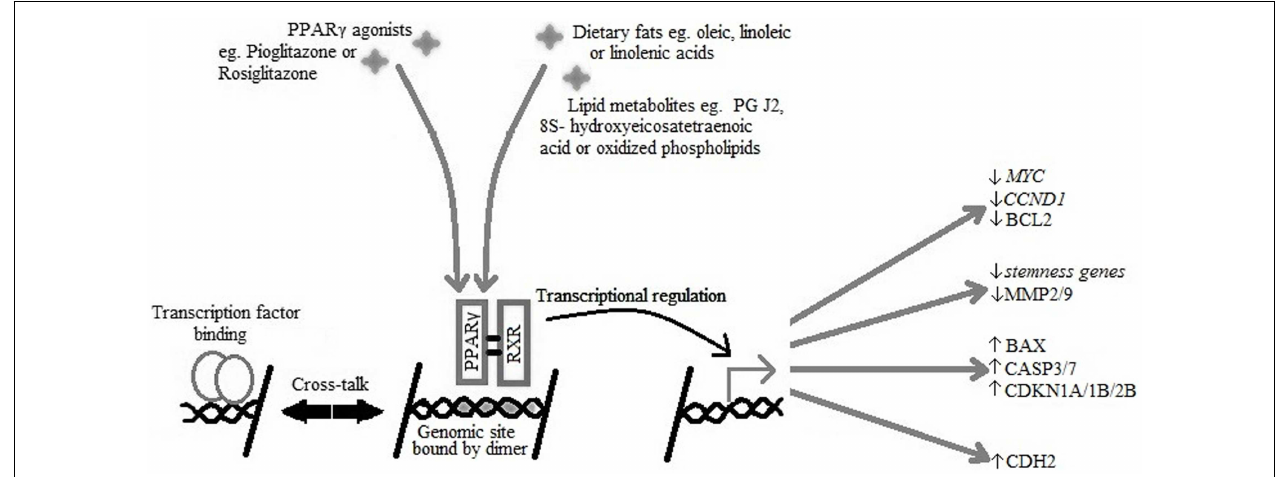
FIGURE 1 | PPAR γ and RXR heterodimer binding to the PPAR γ genomic binding site in DNA causing transcriptional activation of target genes active in cell-cycle arrest, reduced expression of stemness markers, initiation of apoptosis, and re-differentiation .